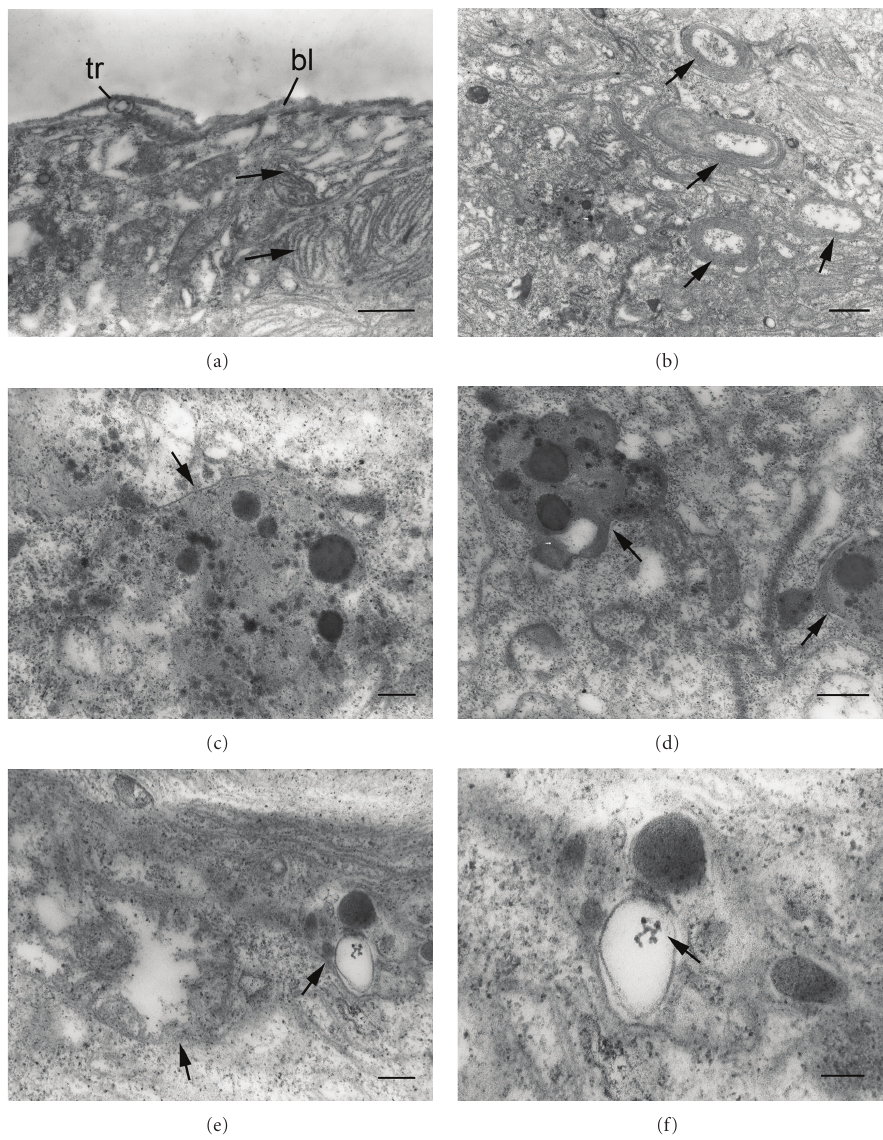
Figure 3: TEM micrographs of the salivary gland in adult male C. megacephala . (a) Salivary gland cells highlighting the basal lamina (bl), and infoldings of the basement membrane (arrows). Evidence of small tracheole (tr) insertion. Bar = 1 µ m. (b) The gland cell cytoplasm showing aggregation of the oval reservoir of secretory materials (arrows). Bar = 1 µ m. (c) Secretory reservoirs containing electron dense secretory granules (arrow). Bar = 2 µ m. (d) Aggregation of secretory reservoirs (arrows). Bar = 0.5 µ m. (e) Variable secretory reservoir (arrows). Bar = 0.2 µ m. (f) Secretory reservoir demonstrating globulin-like material (arrow). Bar = 1 µ m.